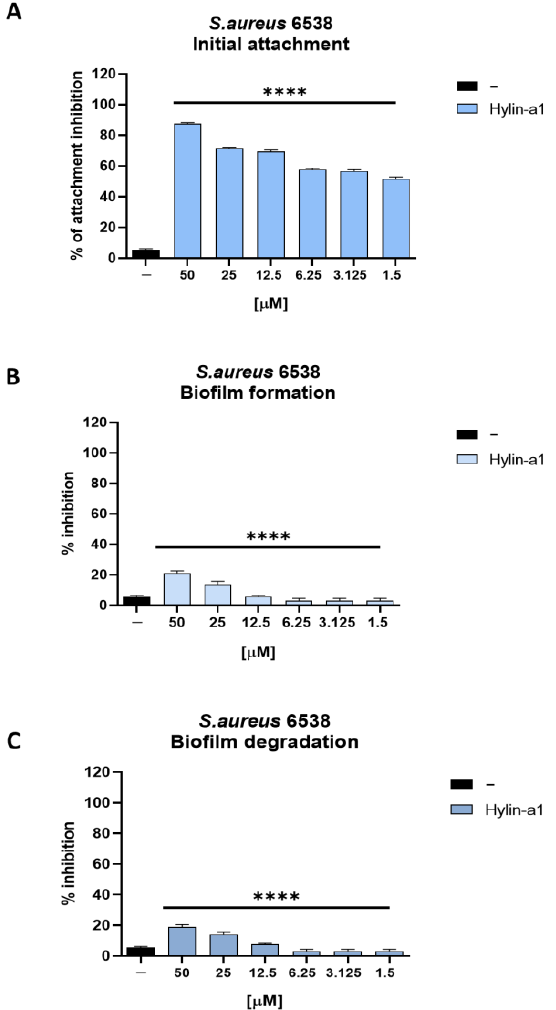
Figure 6. The effect of Hylin-a1 on the biofilm of S. aureus . ( A ) Initial cell attachment for biofilm formation; ( B ) biofilm formation; ( C ) biofilm degradation. **** p < 0.0001. formation; ( B ) biofilm formation; ( C ) biofilm degradation. **** p <